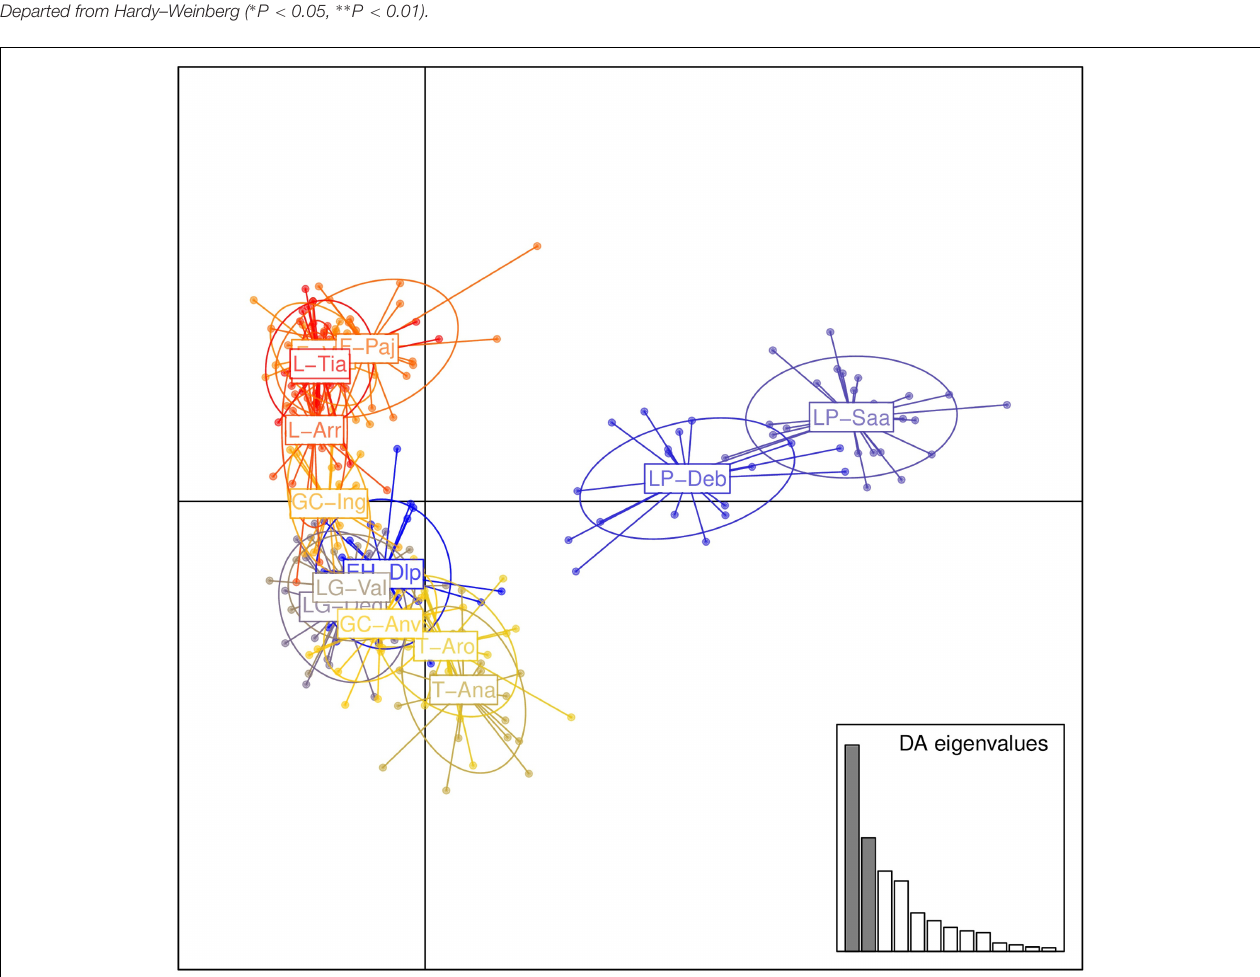
FIGURE 2 | Population structure of Kleinia neriifolia revealed with microsatellite markers using discriminant analysis of principal component. Population codes are same as that in Table 1 .